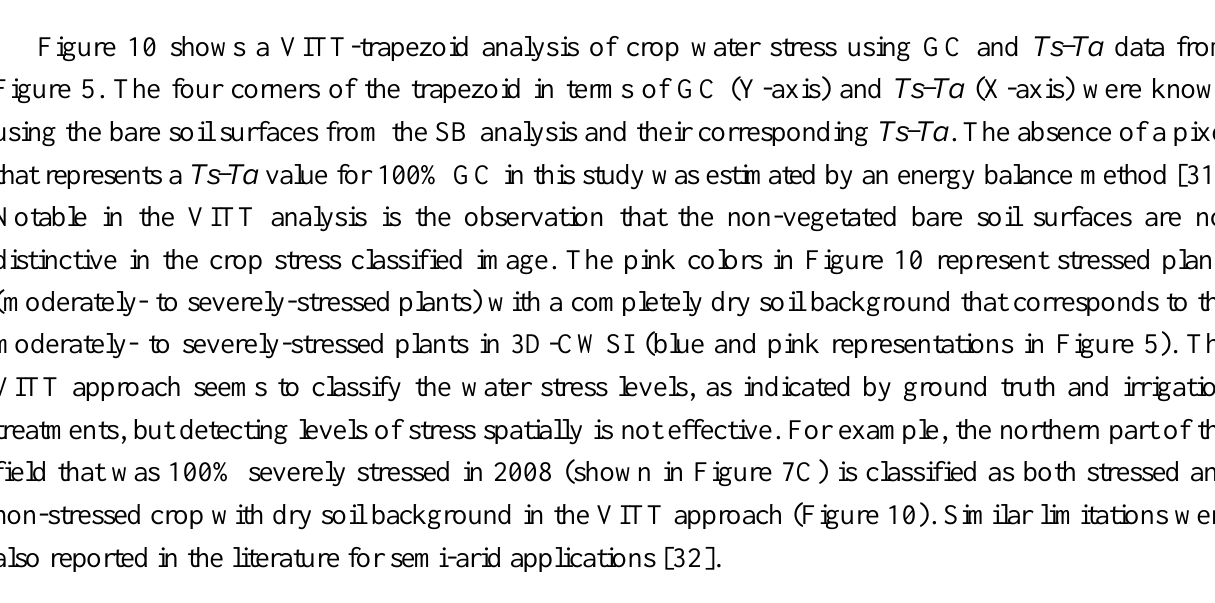
Figure 10. Crop water stress classes for 2007 ( A , B ) and 2008 ( C ) using the Vegetation Index-Temperature Trapezoid (VITT) approach [6] and classes of stress according to the pixel location [31] within the